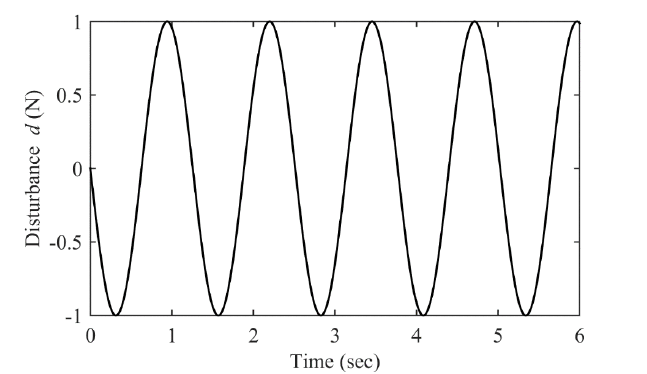
Figure 5. Road disturbances.